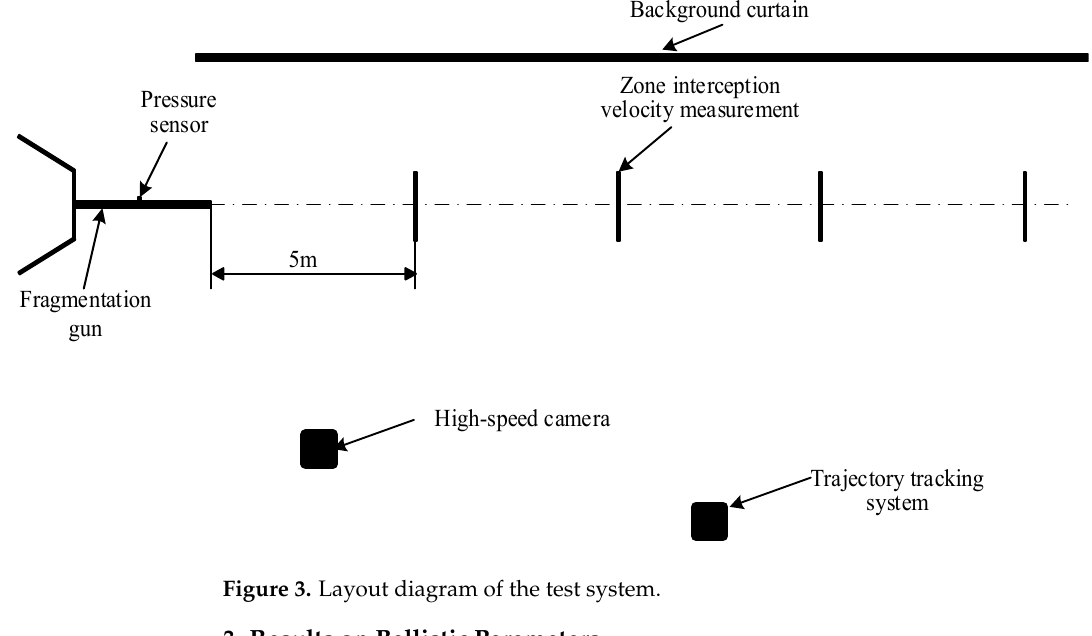
Figure 3. Layout diagram of the test system.